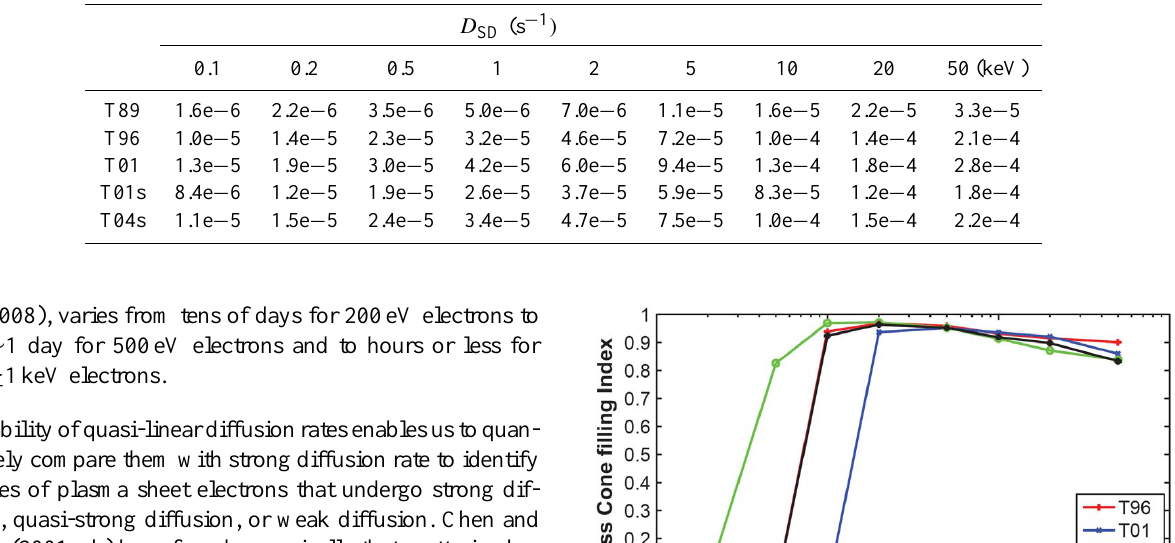
Table 1. Strong diffusion rates for plasma sheet electrons at nine specified energies using different Tsyganenko magnetic field models.